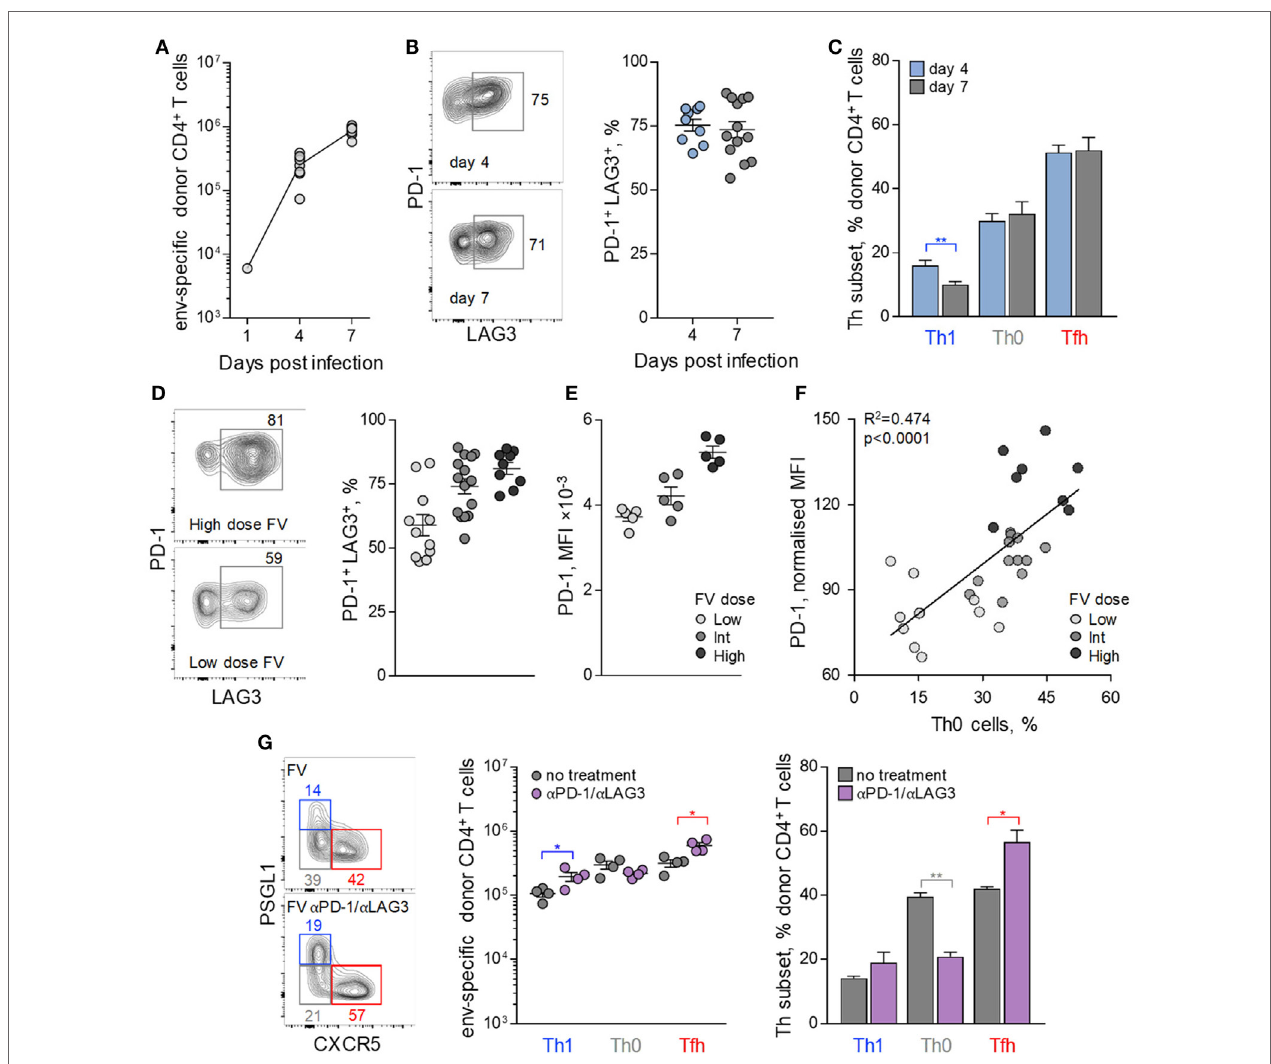
FigUre 3 | Follicular helper (Tfh) cells maturation control by inhibitory receptor induction. CD4 + EF4.1 T cells were adoptively transferred into WT recipients infected with intermediate dose of Friend virus (FV) and analyzed by flow cytometry in the spleens on days 4 ( n = 9) and 7 ( n = 13) post-transfer and infection. (a) Absolute number of env-reactive CD4 + T cells were recovered. (B) Flow cytometry profile ( left ) and mean frequency ( ± SEM) ( right ) of PD-1 + LAG3 + cells within env-reactive donor CD4 + T cells. Each symbol is an individual mouse. (c) Mean frequency ( ± SEM) of T helper (Th) subsets, defined by PSGL1 and CXCR5 expression, in env-reactive donor CD4 + T cells. (D) Representative flow cytometric profile of PD-1 and LAG3 expression ( left ), mean frequency ( ± SEM) of PD-1 + LAG3 + cells, and (e) mean fluorescence intensity (MFI) of PD-1 staining in env-reactive CD4 + T cells isolated from the spleens of recipient mice on day 7 post transfer and infection with the indicated dose of FV. Each symbol is an individual mouse ( n = 11, n = 14, and n = 9 for low, intermediate and high FV dose, respectively). (F) Correlation between the frequency of Th0 cells and the MFI of PD-1 expression in env-reactive donor CD4 + T cells from the same mice described in (D) . (g) Flow cytometric analysis ( left ), absolute number ( middle ), and mean frequency ( ± SEM) ( right ) of Th subsets, defined by PSGL1 and CXCR5 expression, in env-reactive donor CD4 + T cells, 7 days after transfer into FV-infected recipients with or without additional treatment with PD-1 and LAG3 blocking antibodies ( n = 4 from one of two representative